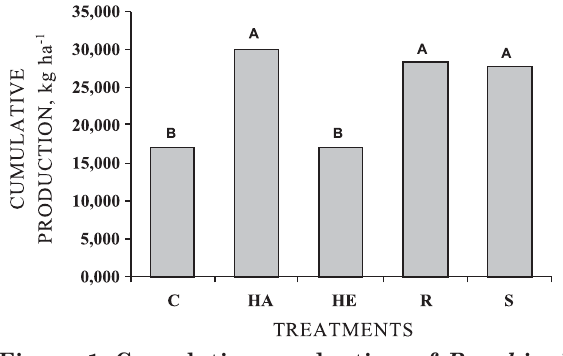
Figure 1. Cumulative production of Brachiaria brizantha in treatments C, HA, HE, R and S from September 2004 to March 2005. Capital letters compare treatments with each other (p <